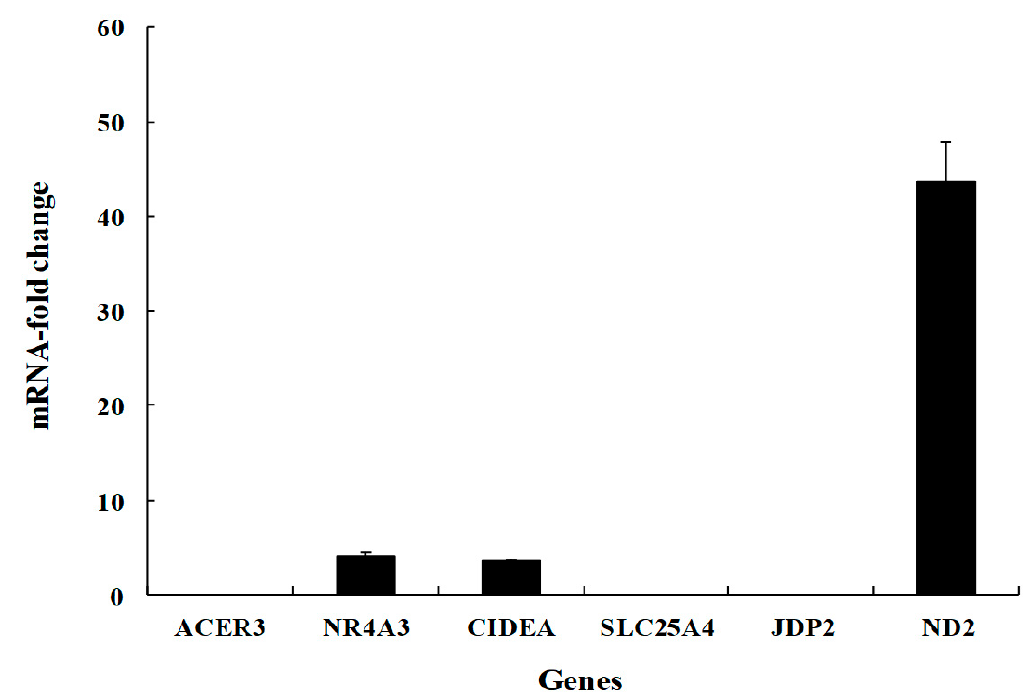
Figure 5. Quantitative real-ti me PCR of di ff erentially expressed genes. Genes expressed over 2-fold in the infected 2-week-old ducks compared to those in the infected 4-week-old ducks using oligo dT primers and SYBR die. * p < 0.05; ** p < 0.001.